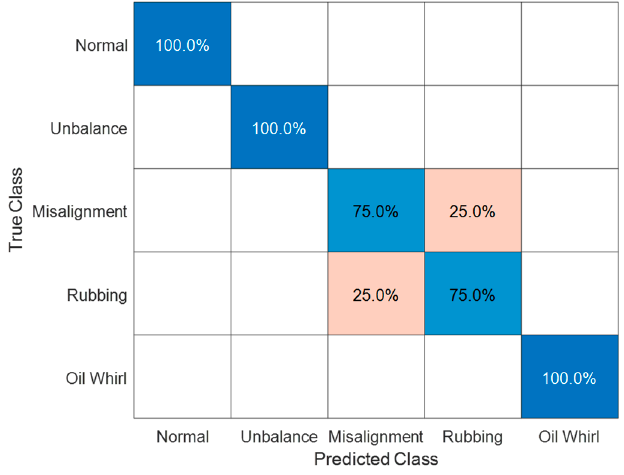
Figure 14. Test confusion matrix of cubic SVM on features automatically extracted by the pretrained deep learning model from the original RK4 data.